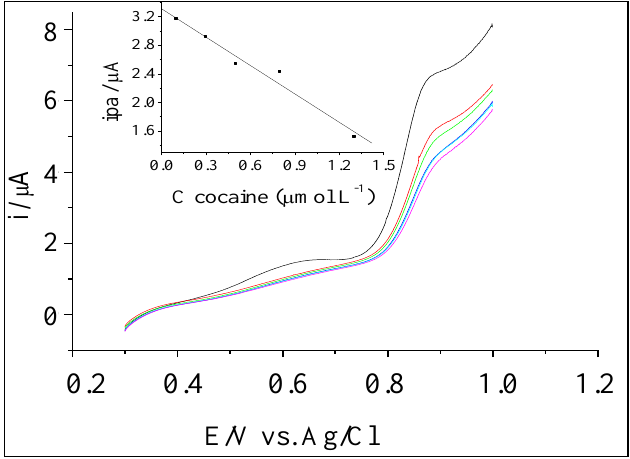
(5-MeO-salen)(H O)]·H O. 2 2 2